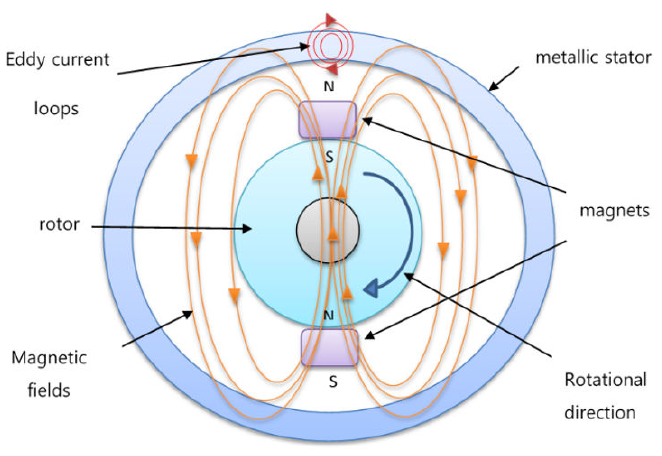
Figure 1. Eddy current principle